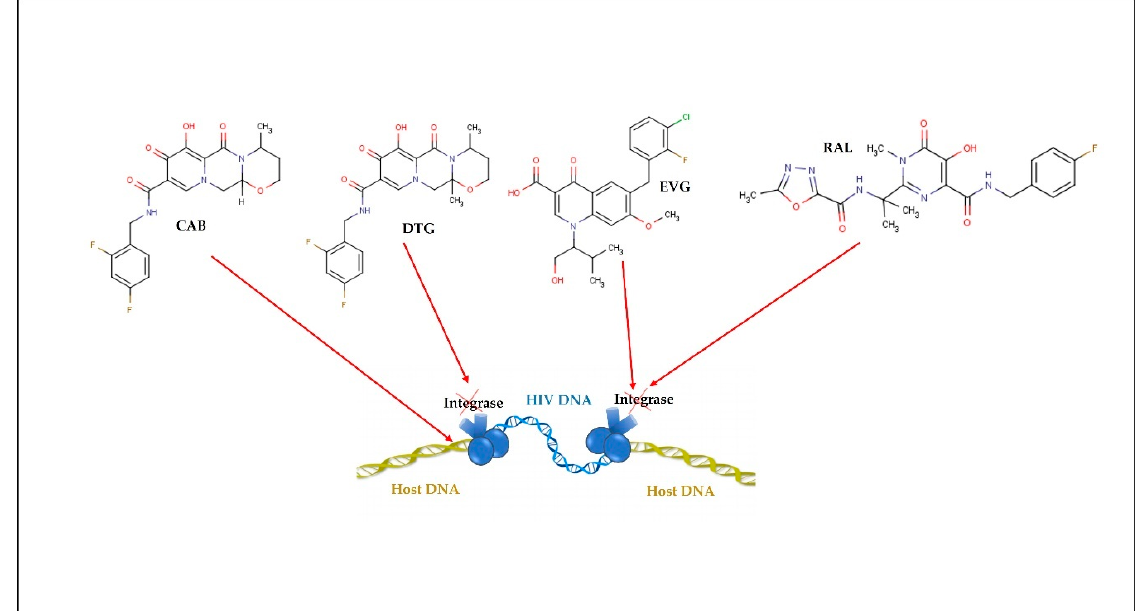
Figure 5. Integrase inhibitors: raltegravir (RAL); dolutegravir (DTG); elvitegravir (EVG); cabotegravir (CAB).